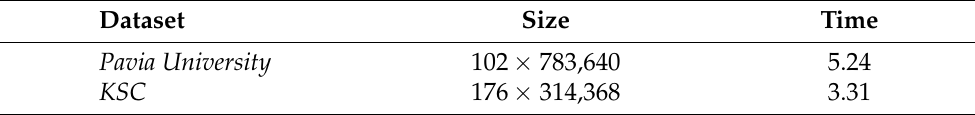
Table 4. Computational time in